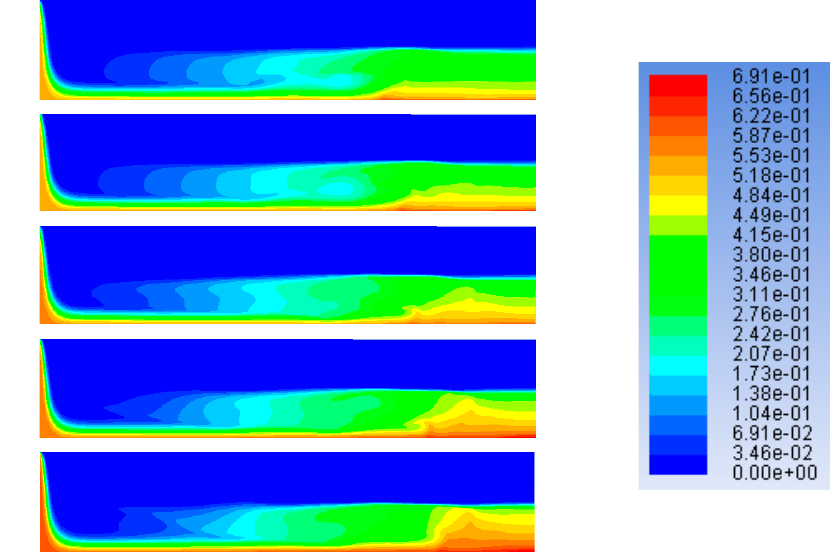
Figure 9. Gravel settlement diagram with different sand concentrations.